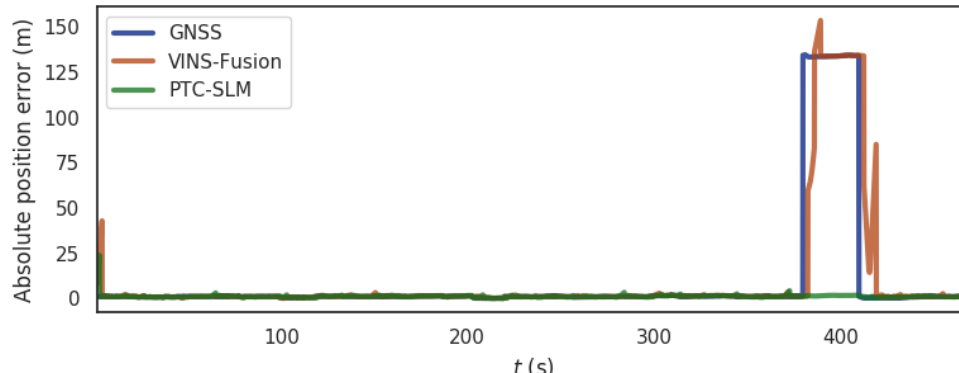
Figure 12. The absolute position error of the three methods in urban scene .